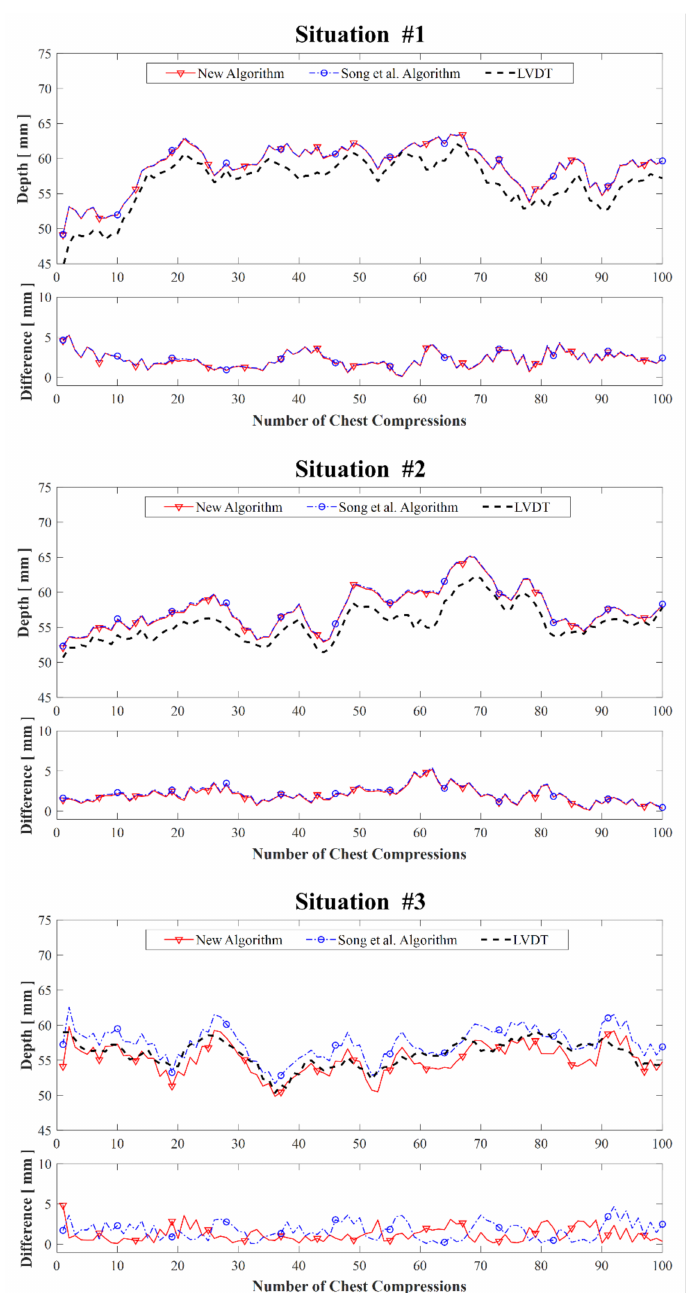
Figure 8. Comparison of depth and error for each situation shown in Figure 6. For the estimated CPR depth of the smart ring, the error results with the adult mannequin (3.1 ± 1.9 mm) and the two-thumb method on the infant mannequin (2.9 ± 1.8 mm) were similar to those of the estimated depth of ring-based CCD feedback system (1.9 ± 1.1 mm). For the estimated CPR depth of the smartwatch, there was a large difference for adult mannequin LVDT and for the two-thumb method on the infant mannequin. The results of the two-finger method on the infant mannequin were overestimated by both the smart ring and the smartwatch. The overall data patterns in the three CPR experiments showed lower mean and SD in the smart ring data than in the smartwatch data (Table